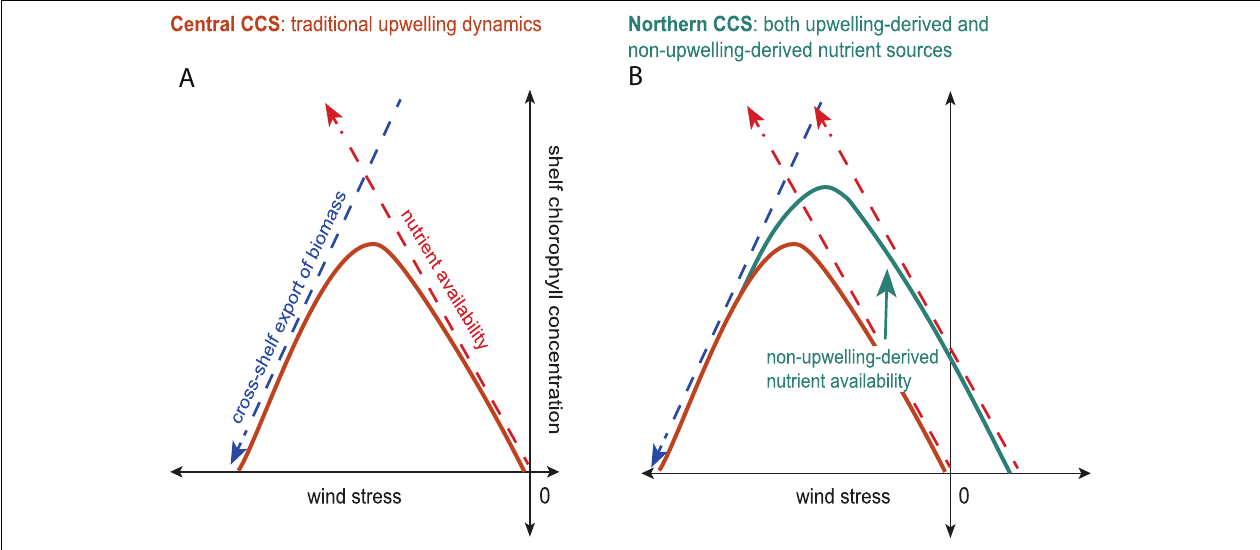
FIGURE 10 | A revised Botsford et al. (2003) relationship for the Central and Northern CCS. The relationship between shelf chlorophyll concentration and wind stress in the Central CCS (orange curve, A ) and in the Northern CCS (teal curve, B ). The chlorophyll response to nutrient availability supplied by upwelling-favorable wind stress is depicted by the red dashed arrow, while the chlorophyll response to cross-shelf export of biomass is depicted by the blue dashed arrow. Non-upwelling-derived nutrient availability (teal arrow in B ) in the Northern CCS accounts for the increase in overall nutrient availability and shift of the shelf chlorophyll response to wind stress (teal curve) into downwelling-favorable wind stresses ( B